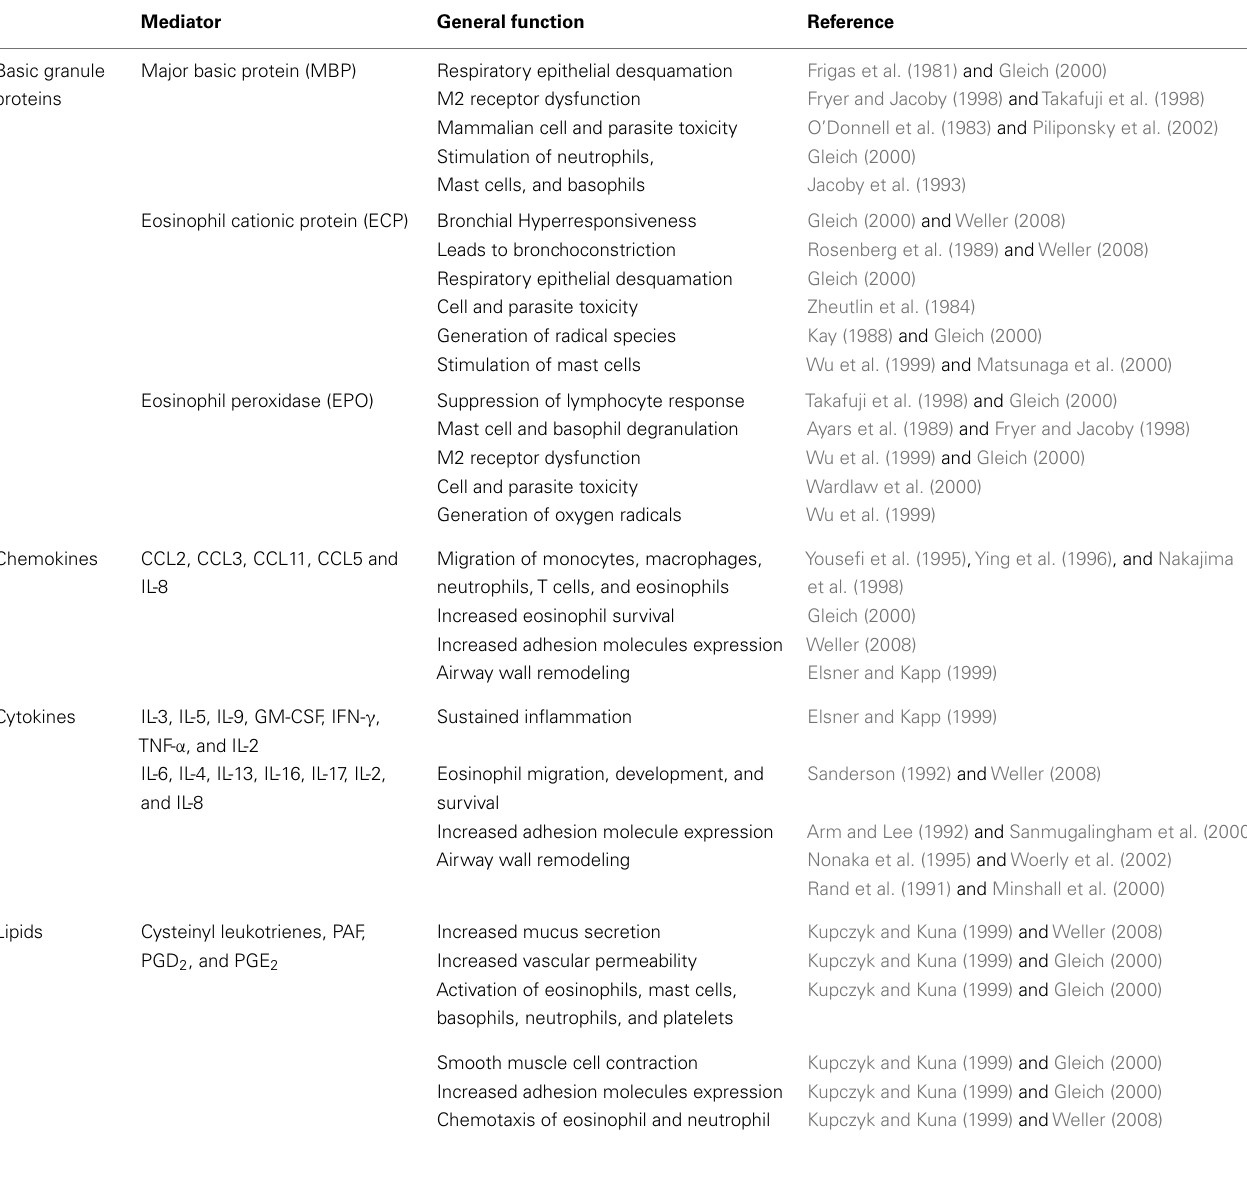
Table 2 | Mediators released by